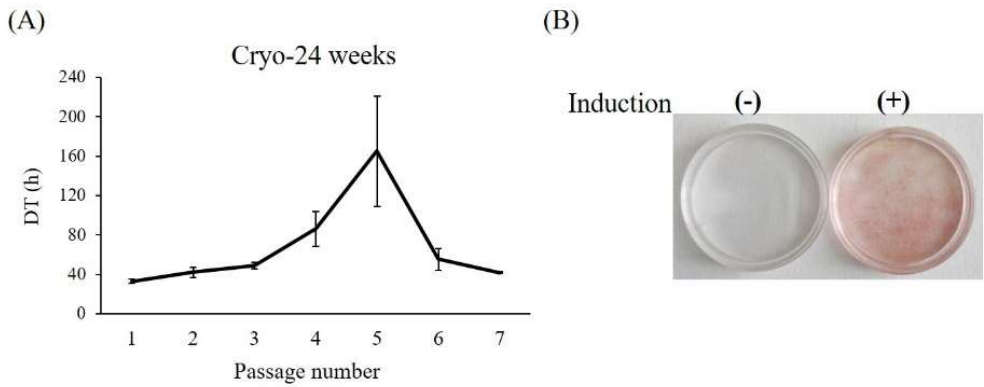
Figure 6. Long-term cryopreserved adipose-tissue-derived cells. ASCs were isolated from 24-week-cryopreserved tissues and examined for proliferation and adipogenic differentiation: ( A ) DT; ( B ) Oil red O staining. Data are expressed as the mean ± SE ( n = 4).